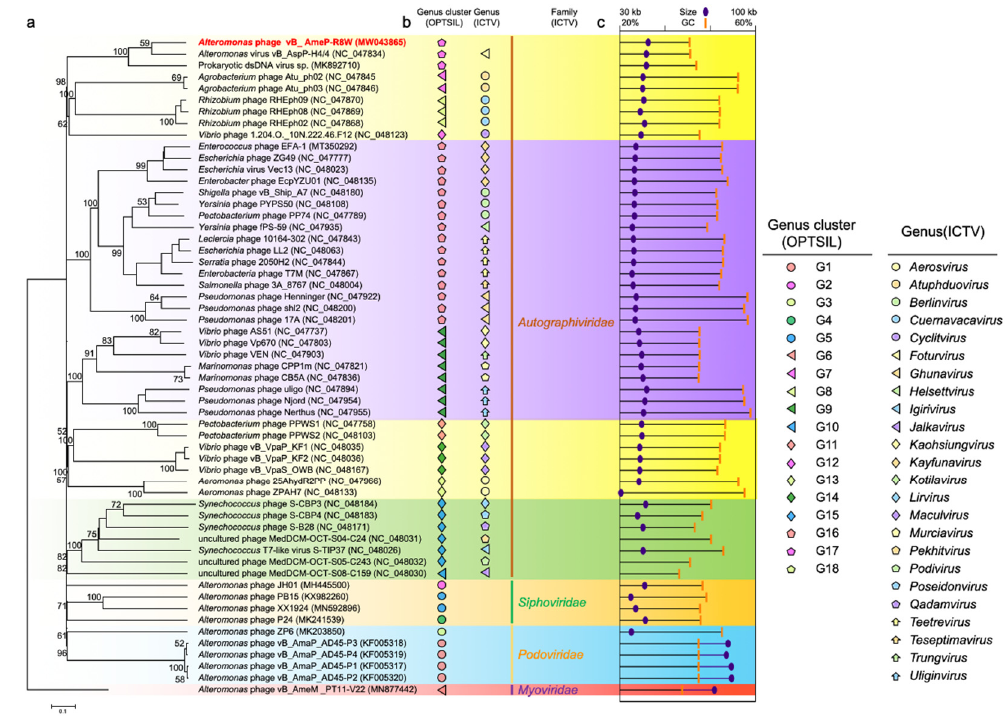
Figure 5. ( a ) Genome BLAST distance phylogeny (GBDP) tree of 57 virus genomes. Based on nucleotide sequences, the GBDP tree is reconstructed by VICTOR, which used the D6 formula and yielded an average support of 71%. Numbers at the nodes are GBDP pseudo-bootstrap values (100 replications and values >50%). ( b ) ICTV and OPTSIL clusters at the genus and family levels. Each genus is indicated by a unique shape and color. Background colors indicate the 8 OPTSIL clusters at the family level. ( c ) G + C content and genome sizes.